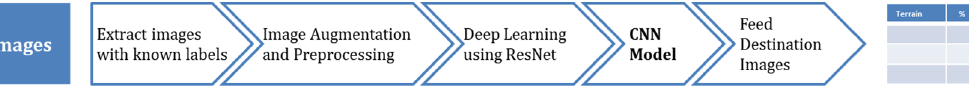
Figure 5. Overview of prototype development of thematic TRS.